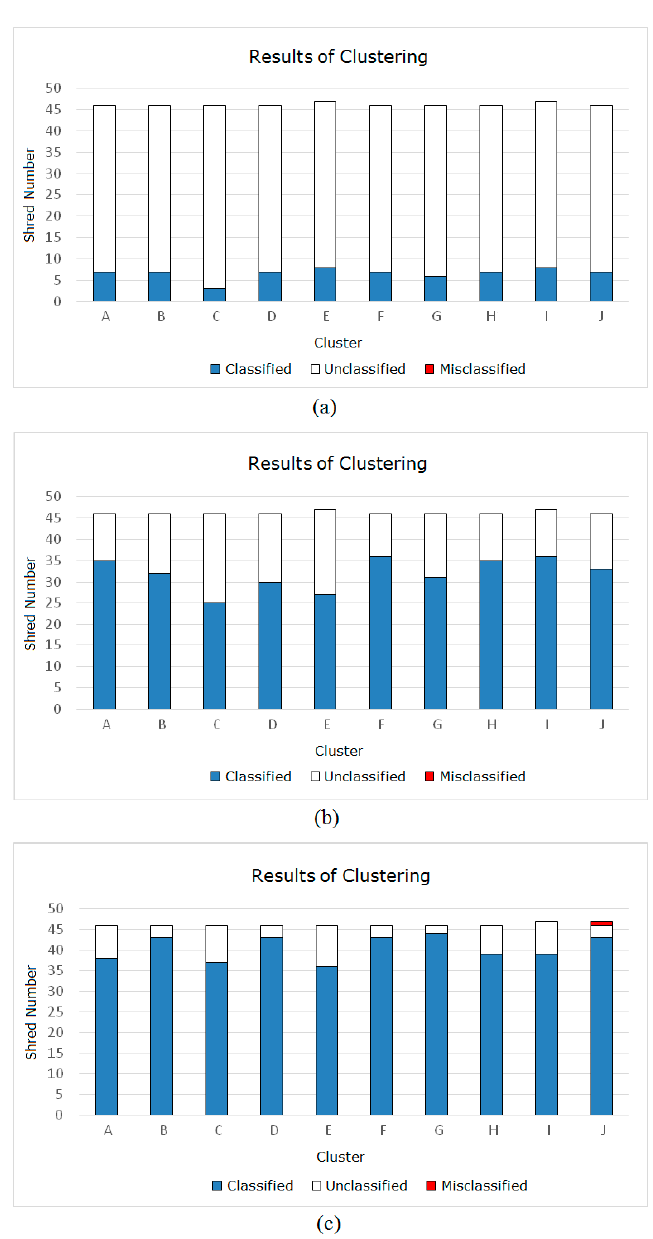
Figure 20. Clustering results of each stage of Section 2.3: ( a ) clustering results after Section 2.3.1 processing; ( b ) clustering results after Section 2.3.2 processing; ( c ) clustering results after Section 2.3.1 processing.